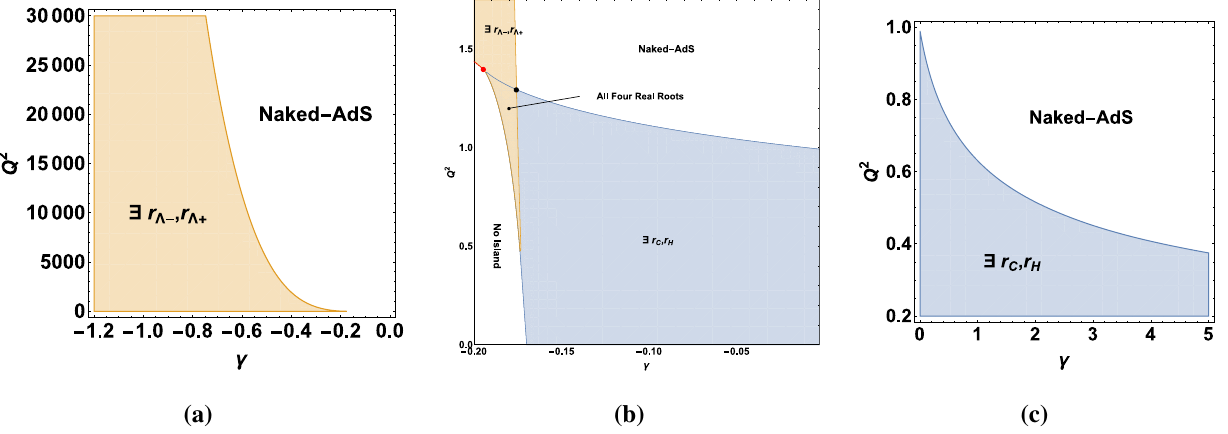
Q 2 where various scenarios occur, red dot is the end of two extremal